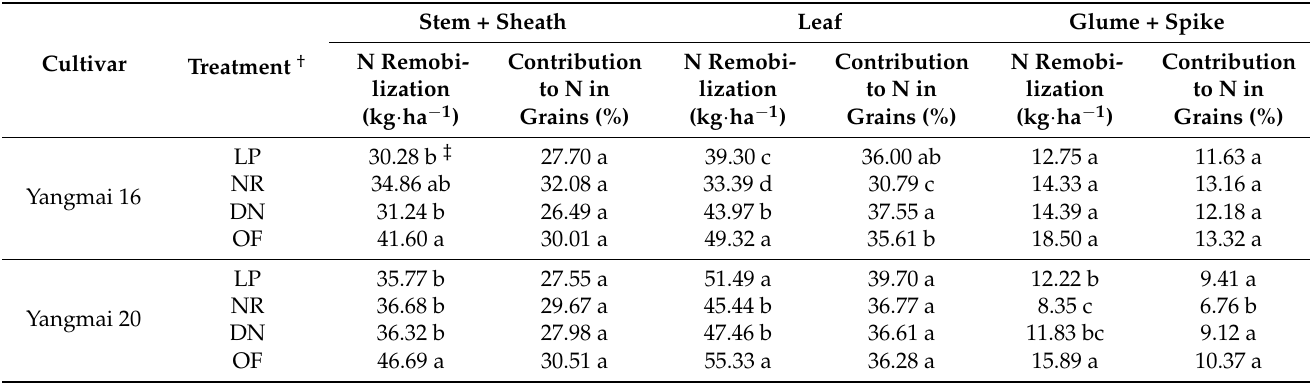
Table A1. Contribution of nitrogen transfer in various organs to grains during the grain filling stage in